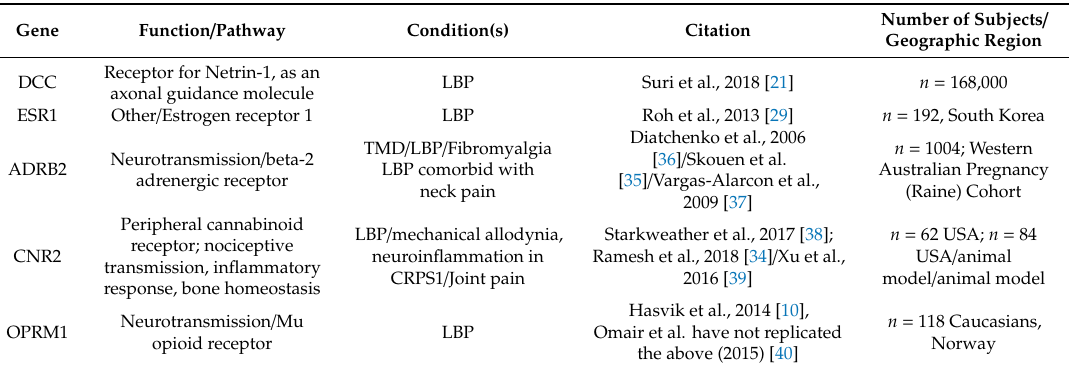
Table 1. Receptor-related